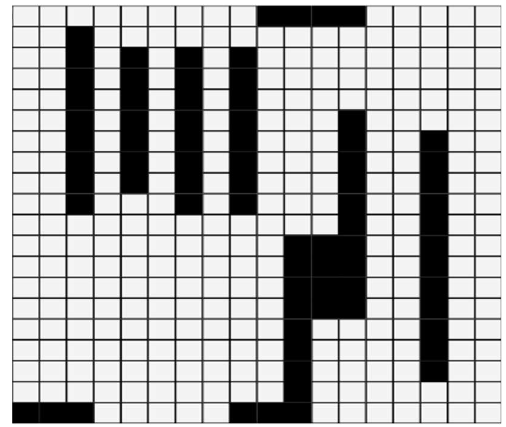
Figure 3. Raster simulation diagram.